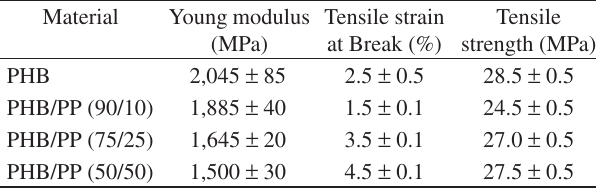
Table 6. Mean tensile values of the PHB and PHB/PP blends.